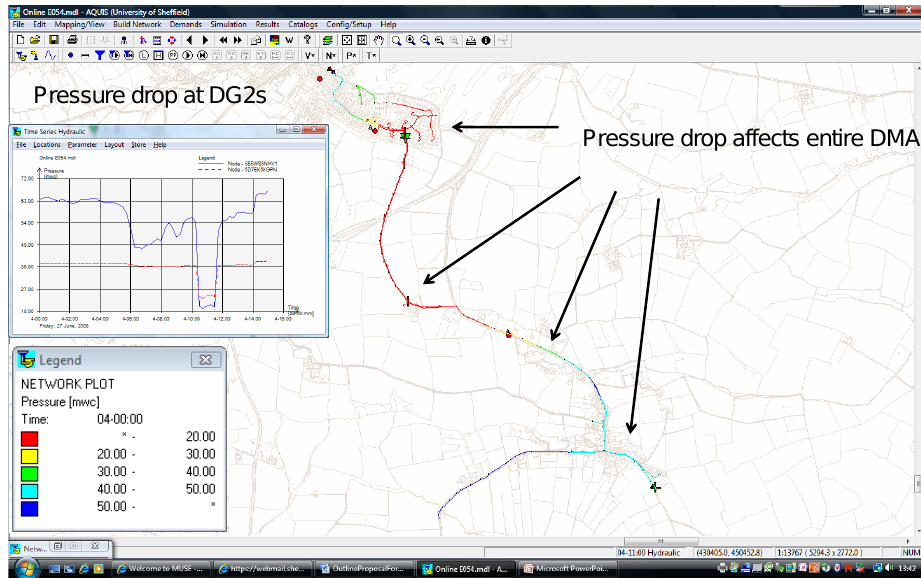
Figure 6. Pressure e ff ect of event at